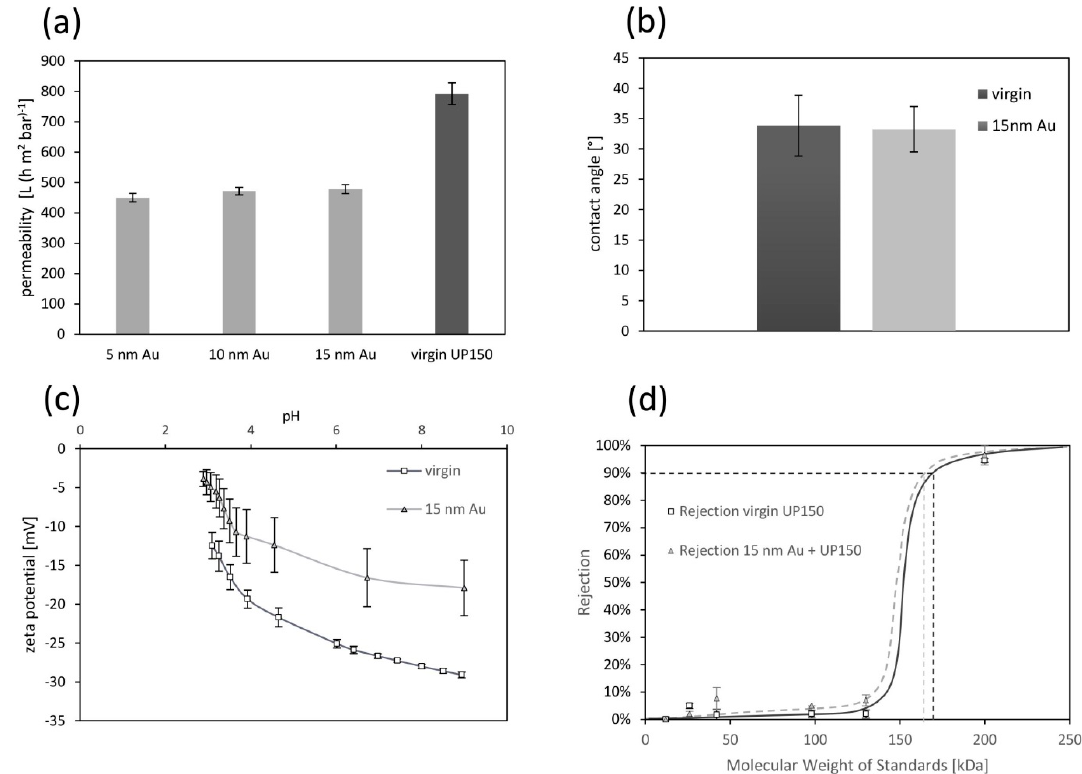
Figure 2. Membrane characterization virgin vs. gold coated UP150: ( a ) pure water permeability; ( b ) contact angle; ( c ) Zeta potential at 1 mol L − 1 KCl; ( d ) molecular weight cut-off with estimated separation curves, error bars present standard deviations.